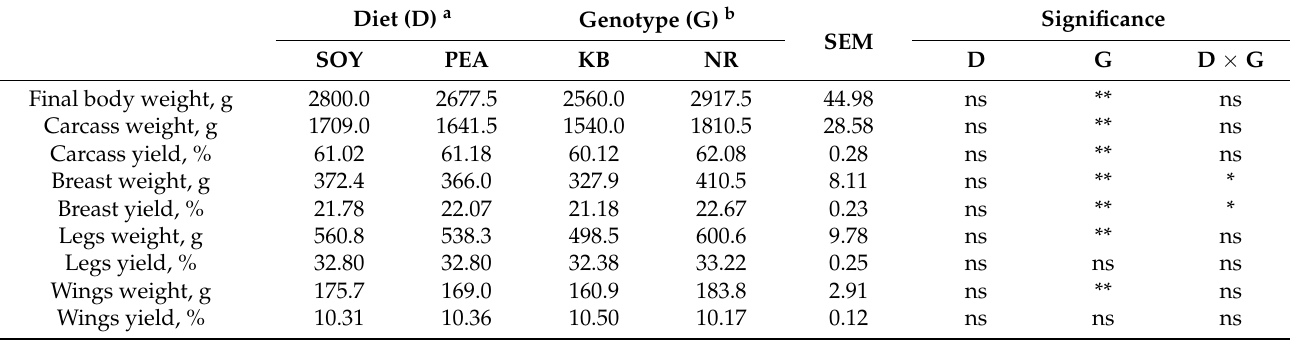
Significance SEM